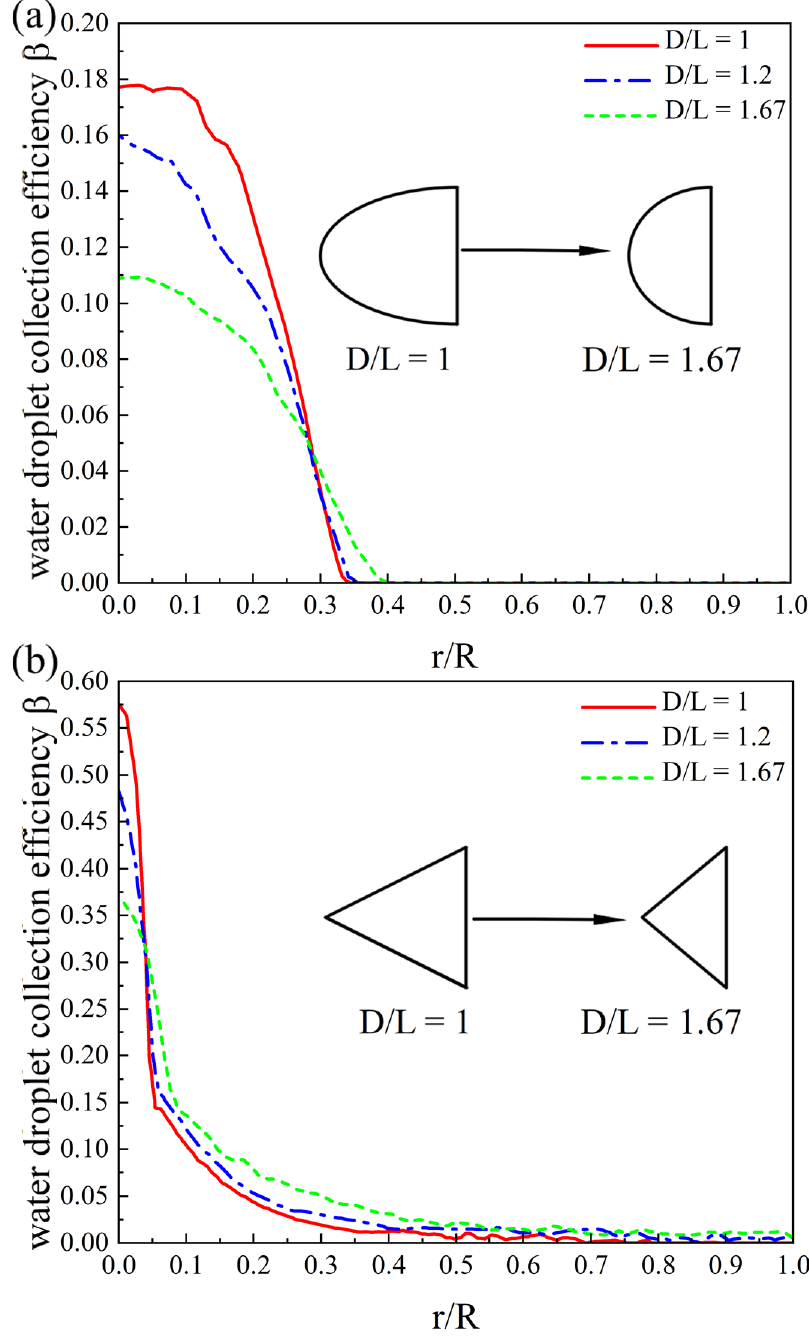
Figure 15. Influence of D/L on water droplet collection efficiency: ( a ) elliptical spinner; ( b ) conical spinner.